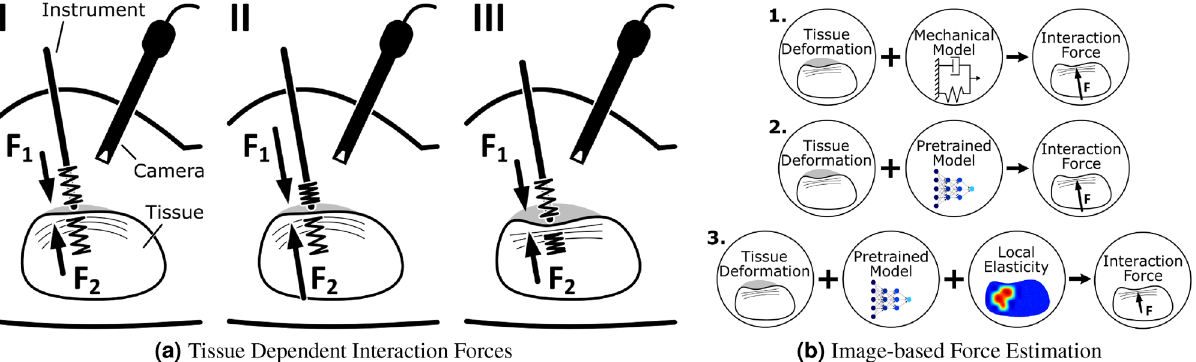
Figure 1. Image-based Force Estimation: (a) Abstract illustration of the fundamental problem underlying force estimation without integrated sensors. The springs indicate elastic properties and the camera observes tissue deformations. (I) During tool-tissue interaction, the applied force F 1 will deform the tissue and the opposing reaction force F 2 will be equal in magnitude. However, the same deformation can be related to greater forces for stiffer tissue (II) or the same force may result in larger deformations for softer tissue (III). Therefore, observing only the deformation will generally not allow estimating the interaction forces if the tissue elasticity is unknown. (b) Previous approaches have not considered changes in elastic properties and relied on predefined biomechanical models (1.) or pretrained neural networks (2.) to derive interaction forces from the